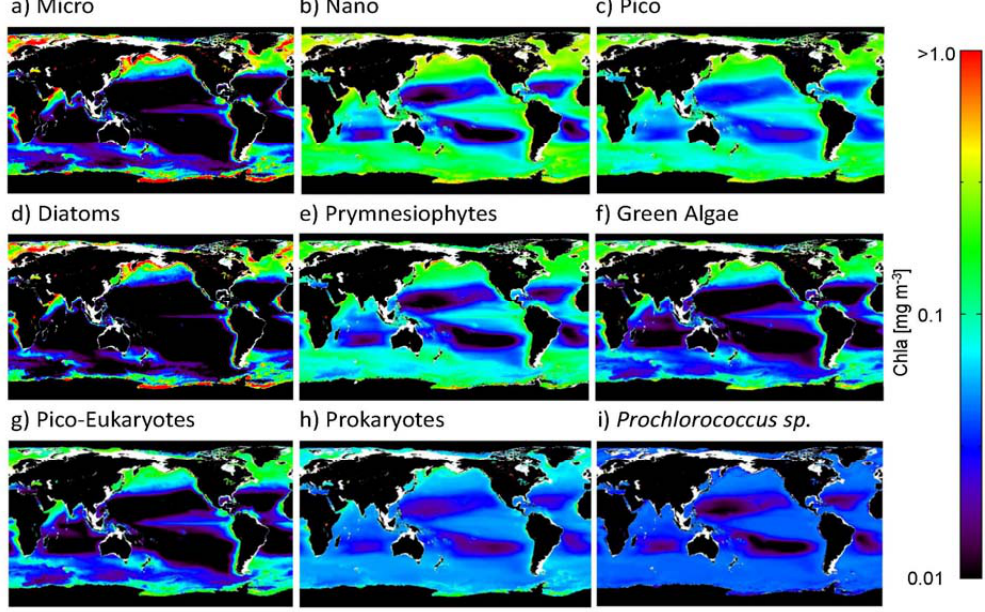
Fig. 7. Synoptic distribution of mean surface Chl- a (mg m − 3 ) of PSCs (a–c) and PFTs (d–i) over 1998–2009 derived from SeaWiFS; (a) Microplankton (global average ∼ 0.11mgm − 3 ) , (b) Nanoplankton (0.12mgm − 3 ) , (c) Picoplankton (0.08mgm − 3 ) , (d) Diatoms (0.09mgm − 3 ) , (e) Green Algae (0.04mgm − 3 ) , (f) Pico-eukaryotes (0.04mgm − 3 ) , (g) Prymnesiophytes (Haptophytes) (0.08mgm − 3 ) , (h) Prokaryotes (0.04mgm − 3 ) , (i) Prochlorococcus sp. (0.03mgm − 3 ) . White area shows a continental shelf mask defined by < 200 m.